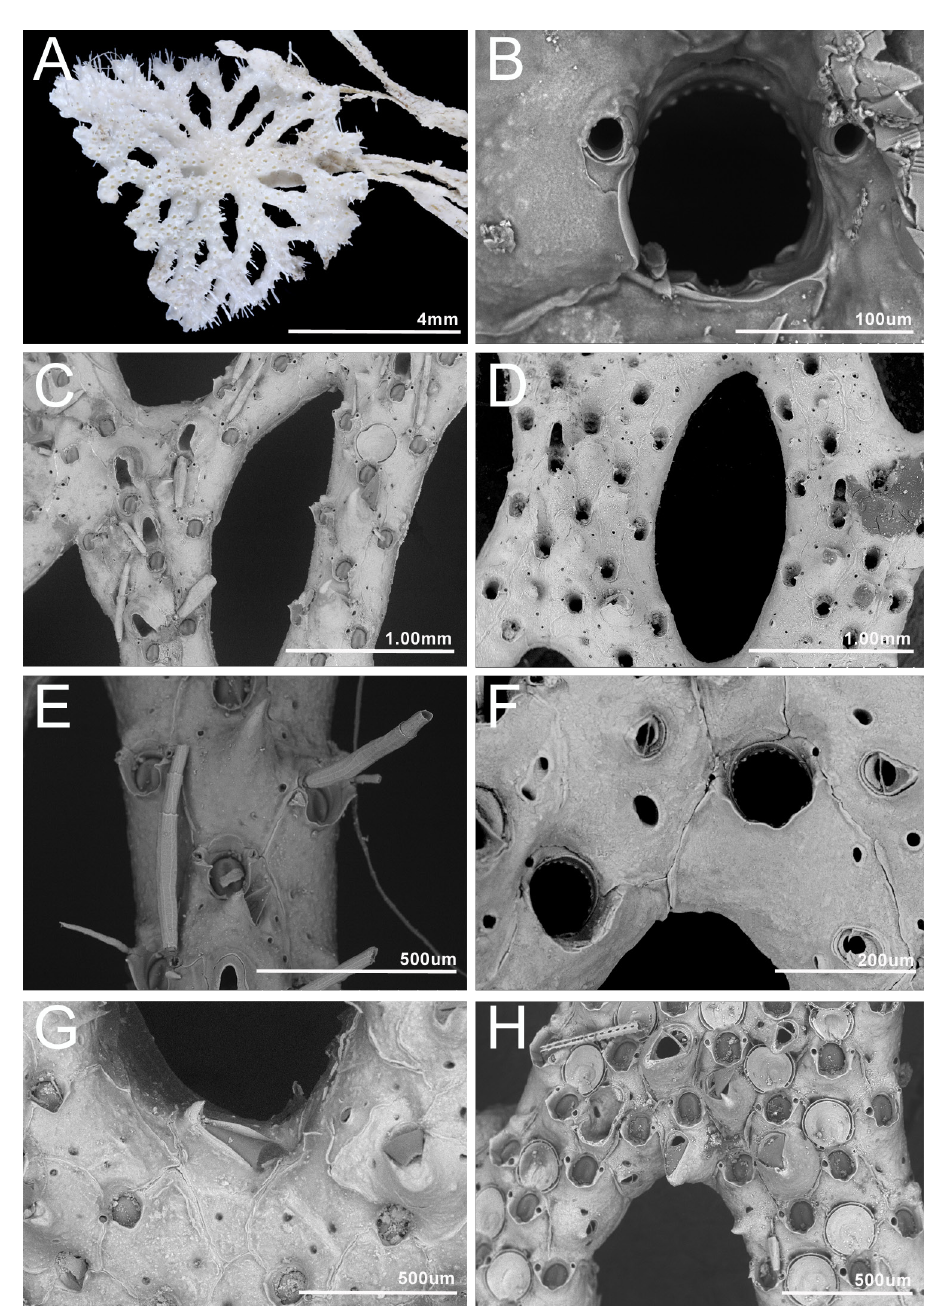
Fig. 9. Schizoretepora pungens (Canu & Bassler, 1925). A from specimen labelled as Schizellozoon longisetae , Gautier leg. (MNHN-IB-2008-11127); B, H from specimen labelled as Retepora imperati , coll. Canu (MNHN-IB-2014-29); C from specimen labelled as Schizellozoon longisetae (MNHN- IB-2008-14462); D from Schizoretepora pungens , holotype, coll. Canu (MNHN-IB-2014-20); E from Schizoretepora pungens (MNHN-IB-2008-14434); F from specimen labelled as Retepora imperati (MNHN-IB-2008-982); G from specimen labelled as Retepora imperati , coll Calvet (MNHN- IB-2008-6052). A . Young colony with spines. B . Primary orifice showing distal denticles, proximal condyles, sinus and smothered peristome. C . Young autozooids showing spines and acute peristomes. D . Old autozooids lacking spines and with smothered peristomes. E . Detailed view of articulated and carenated club-like spines. F . Adventitious triangular (upper side) and oval (bottom right) avicularians. G . Giant avicularium at basis of fenestra. H . Giant avicularia on large cystids showing crossbar without